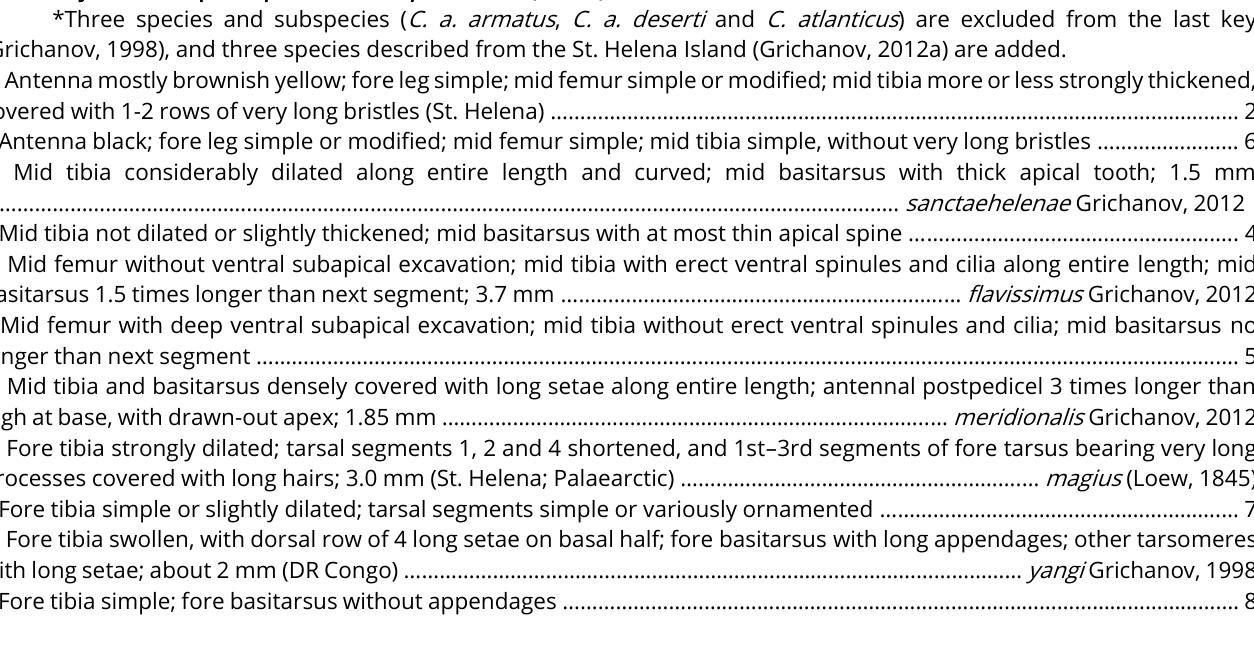
Campsicnemus armatus deserti Vaillant, 1953: 11 (as var. of C. armatus); Negrobov, 1991: 59 (as a subsp. of C. armatus; unavailable name according to ICZN, 45.6.4.1, as published after 1980). Type locality: not given [SE Algeria: Tassili n’Ajjer]. MATERIAL. Ethiopia: 2 ♂ , Oromia, Ziwai L., 7.91°N, 38.73°E, 1640 m, 11–13.II.2012, N. Vikhrev (ZMUM); Namibia: 2 ♀ , Katima Mulilo Distr., Salambala Forest at: 17°50.066 ʹ S / 24°36.225 ʹ E, 926 m, Malaise trap, 18–20.XI.2012, 926 m, A.H. Kirk- Spriggs / Miombo and Moppane woodlands (BMSA); South Africa: 1 ♂ , Free State, Brandfort, Florisbad Res. Stat., 28°46.039’S, 26°04.234’E, 25-29.X.2010, A.H. Kirk-Spriggs / Malaise traps, Acacia savanna (BMSA); 1 ♀ , Free State,Harrismith Scotland Farm, 27°28.595’S, 29°37.098’E, 10-12.XI.2009, A.H. Kirk-Spriggs / Malaise traps, dense Leucosedea dominated scrub (BMSA); 2 ♂ , 1 ♀ , Western Cape, Gamkaskloof (Die Hel), 33°21.808’S, 21°37.650’E, 16-18.X.2012, 336 m, A.H. Kirk-Spriggs / Malaise traps, Karoo and valley, Acacia woodland (BMSA); 1 ♀ , same label, but 12-13.IX.2013; 1 ♂ (in ethanol), KZN, Royal Natal Nature Reserve, Gudu Forest, 28°40.90'S, 28°55.78'E, 1680-1730m, 22.9-17.XI.2006, Mostovski M.B., MT (NMSA). DISTRIBUTION. Afrotropical: Ethiopia, Namibia, South Africa; Palaearctic: Algeria. First record from Ethiopia. Modified couplets in the key to Palearctic species of Campsicnemus (males) published by Grichanov (2009) 33. Mid tibia without a comb-like ventral row of blunt-ended bristles, with rows of simple hairs and setae; mid basitarsus – Mid tibia with a comb-like posteroventral row of blunt-ended bristles; mid basitarsus distinctly longer than next segment 34. Face dark; postpedicel hardly longer than high at base; legs mainly black; mid tibia without row of long bristles, with full row of erect posteroventral setae, nearly as long as diameter of tibia; 2.3 mm ……………………….… C. zlobini Grichanov, 2012 – Face silvery white; postpedicel 2 times longer than high at base; legs almost completely pale yellow; mid tibia with row of 7-8 bristles in distal 2/3, two times longer than diameter of tibia; 1.3-1.5 mm ….... C. versicolorus Negrobov et Zlobin, 1978 35. Fore coxa with only yellow hairs and bristles; mid tibia usually with 3 dorsal bristles; antennal postpedicel triangular, slightly longer than high at base; 1.5 mm (northern and southern Africa) …………………………………………….. caffer Curran, 1926 – Fore coxa with at least some apical bristles black; mid tibia usually with 4 dorsal bristles; antennal postpedicel triangular 37. Antennal postpedicel triangular, slightly longer than high at base, with rounded apex; mid tibia with a comb-like row of blunt-ended bristles in basal half only; mid femur usually with 1 row of ventral setae; 1.5 (Trans-Palaearctic except subarctic) – Antennal postpedicel elongate triangular, nearly twice longer than high at base, with acute apex; other features various 38. Mid tibia, posteroventrally along almost whole length, with a comb-like row of blunt-ended bristles; mid femur usually with 2 rows of ventral setae; 1.5-2.0 (Trans-Palaearctic except subtropics) ……………………………..... armatus (Zetterstedt, 1849) – Mid tibia with a comb-like row of blunt-ended bristles in basal half only; 1.7-2.4 mm (Iran, Kyrgyzstan, Russia) Key to Afrotropical species of Campsicnemus (males)* *Three species and subspecies (C. a. armatus, C. a. deserti and C. atlanticus) are excluded from the last key (Grichanov, 1998), and three species described from the St. Helena Island (Grichanov, 2012a) are added. 1. Antenna mostly brownish yellow; fore leg simple; mid femur simple or modified; mid tibia more or less strongly thickened, covered with 1-2 rows of very long bristles (St. Helena) ……………………………………………………………………………………………………… 2 – Antenna black; fore leg simple or modified; mid femur simple; mid tibia simple, without very long bristles …………………… 6 3. Mid tibia considerably dilated along entire length and curved; mid basitarsus with thick apical tooth; 1.5 mm – Mid tibia not dilated or slightly thickened; mid basitarsus with at most thin apical spine ……………………………………………….. 4 4. Mid femur without ventral subapical excavation; mid tibia with erect ventral spinules and cilia along entire length; mid – Mid femur with deep ventral subapical excavation; mid tibia without erect ventral spinules and cilia; mid basitarsus no 5. Mid tibia and basitarsus densely covered with long setae along entire length; antennal postpedicel 3 times longer than 6. Fore tibia strongly dilated; tarsal segments 1, 2 and 4 shortened, and 1st–3rd segments of fore tarsus bearing very long processes covered with long hairs; 3.0 mm (St. Helena; Palaearctic) ………………………………………………….… magius (Loew, 1845) – Fore tibia simple or slightly dilated; tarsal segments simple or variously ornamented ………………………………………………….… 7 7. Fore tibia swollen, with dorsal row of 4 long setae on basal half; fore basitarsus with long appendages; other tarsomeres – Fore tibia simple; fore basitarsus without appendages ………………………………………………………………………………………………….…